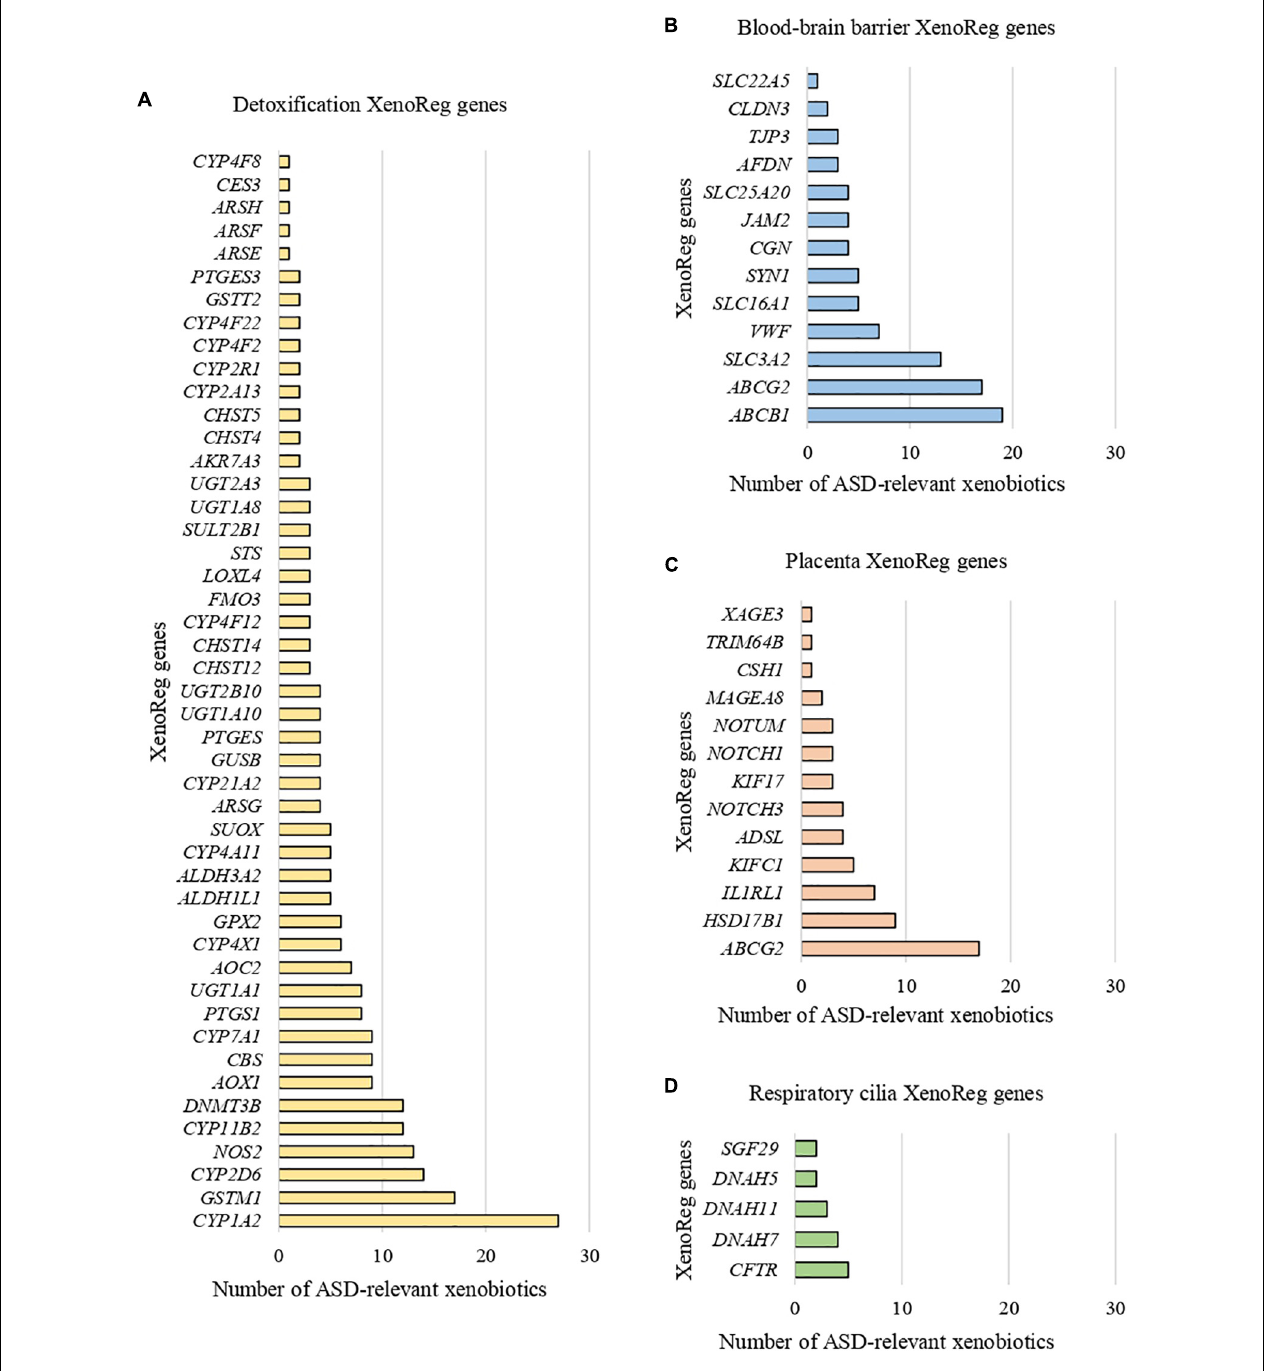
FIGURE 4 | Xenobiotic interactions per high evidence XenoReg gene. Number of xenobiotics previously associated with ASD that interact with each of the 77 high evidence XenoReg genes, according to The Comparative Toxicogenomics Database. (A) Detoxification genes; (B) blood-brain barrier genes; (C) placenta genes; (D) respiratory cilia